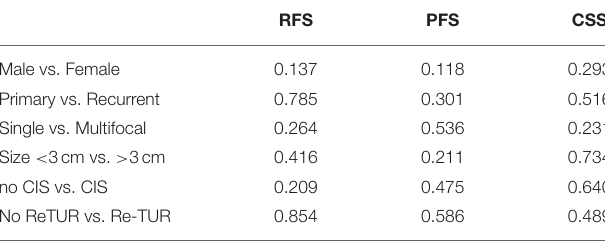
TABLE 4 | Univariate analysis* of impact of tested variables on recurrence-free survival (RFS), progression-free survival (PFS) and cancer-specific survival